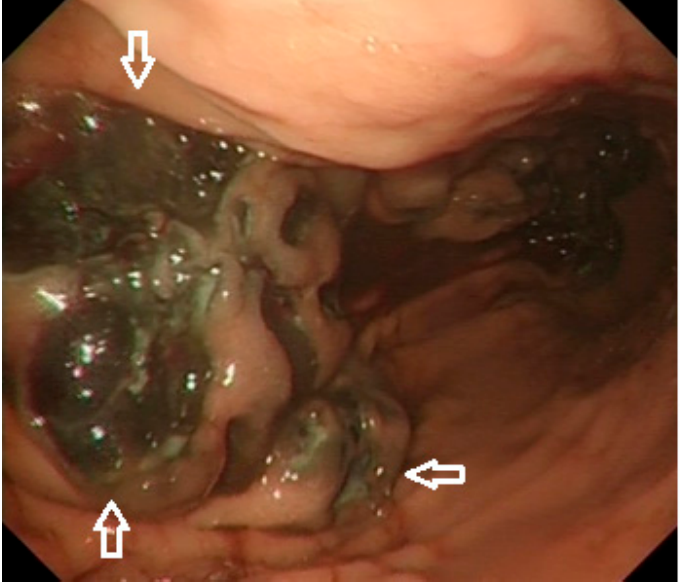
Figure 2. High ‐ definition white light endoscopy: Metastatic malignant melanoma with features of recent bleeding involving the greater curvature of the gastric body (size: 30 × 20 mm; arrows).